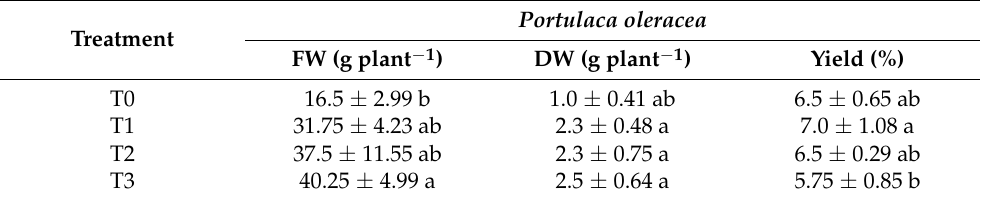
Table 5. Yield of P. oleracea (in the second experiment). Different letters within a column represent significant differences ( p ≤ 0.05).